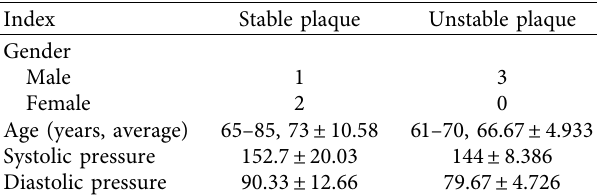
Table 1: Demographic data and chemical detection